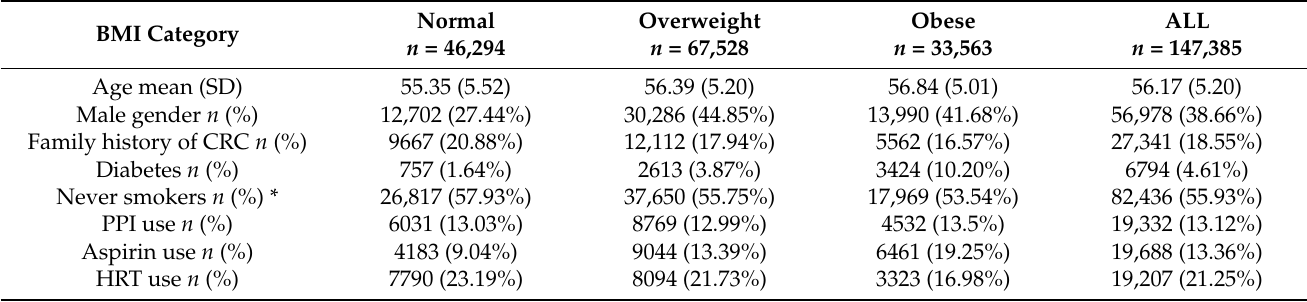
Table 1. Baseline characteristics of the studied population.